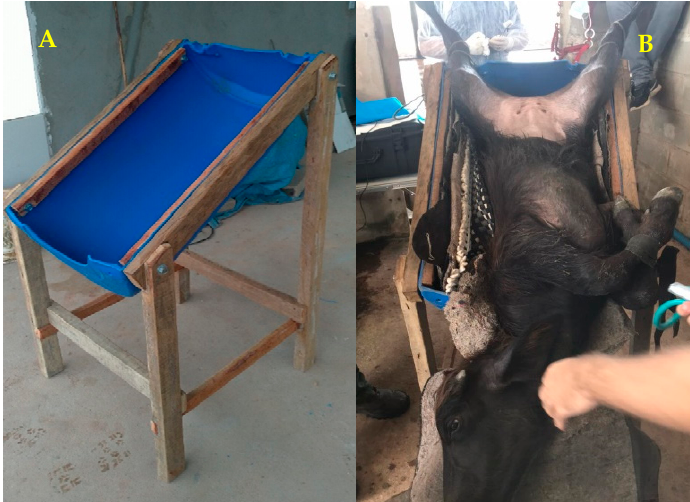
Figure 1. Stretcher adapted to perform the LOPU ( A ). Animal in Trendelenburg position at 45° ( B ).